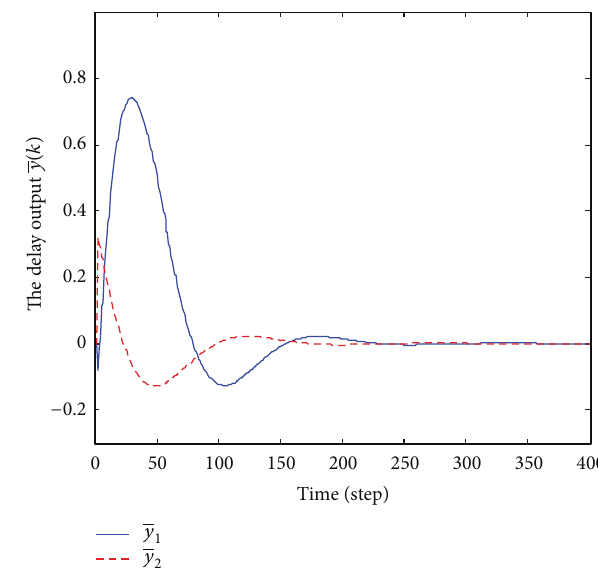
Figure 6: The trajectories of delay output 𝑦(𝑘) .